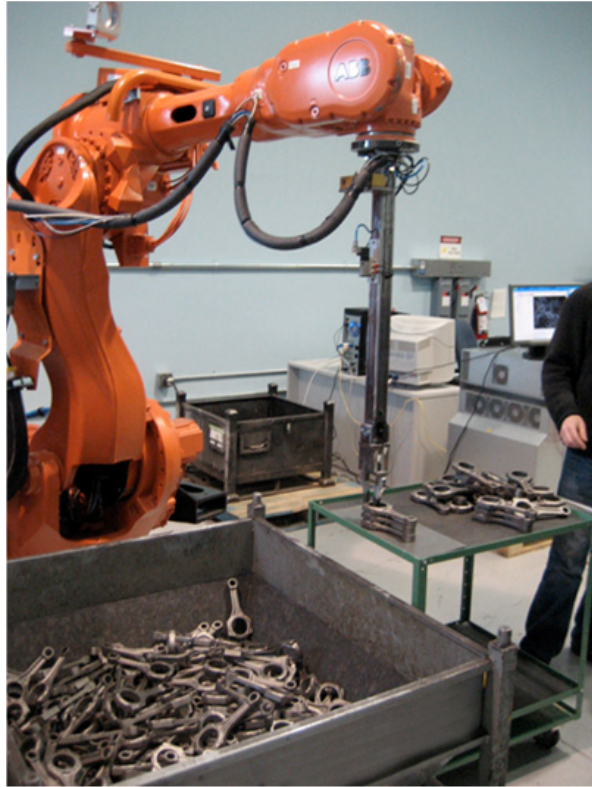
Figure 9: Example of test installation for bin-picking. The gripper is here placed on a long beam to be able to reach the objects everywhere in the deep bin without collisions with the bin walls and without getting too close to